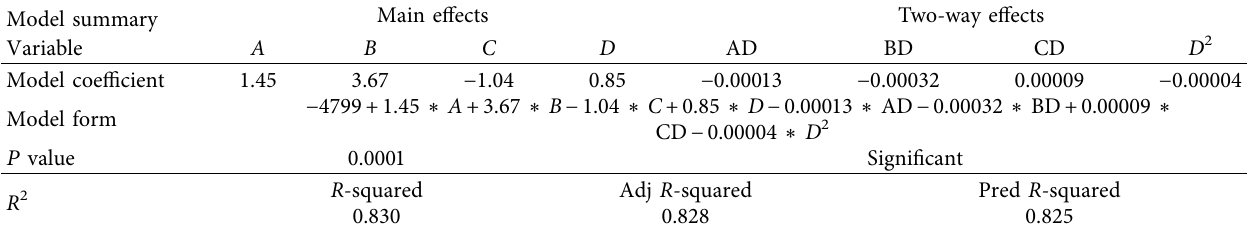
Figure 9: Two-dimensional contour plots of trafc violations at the intersection: (a) JSC versus SNI, (b) JSC versus OTL, and (c) SNI versus OTL for the travel time ratio. Table 10: Efect of decrease in trafc violations and trafc volume on fuel consumption